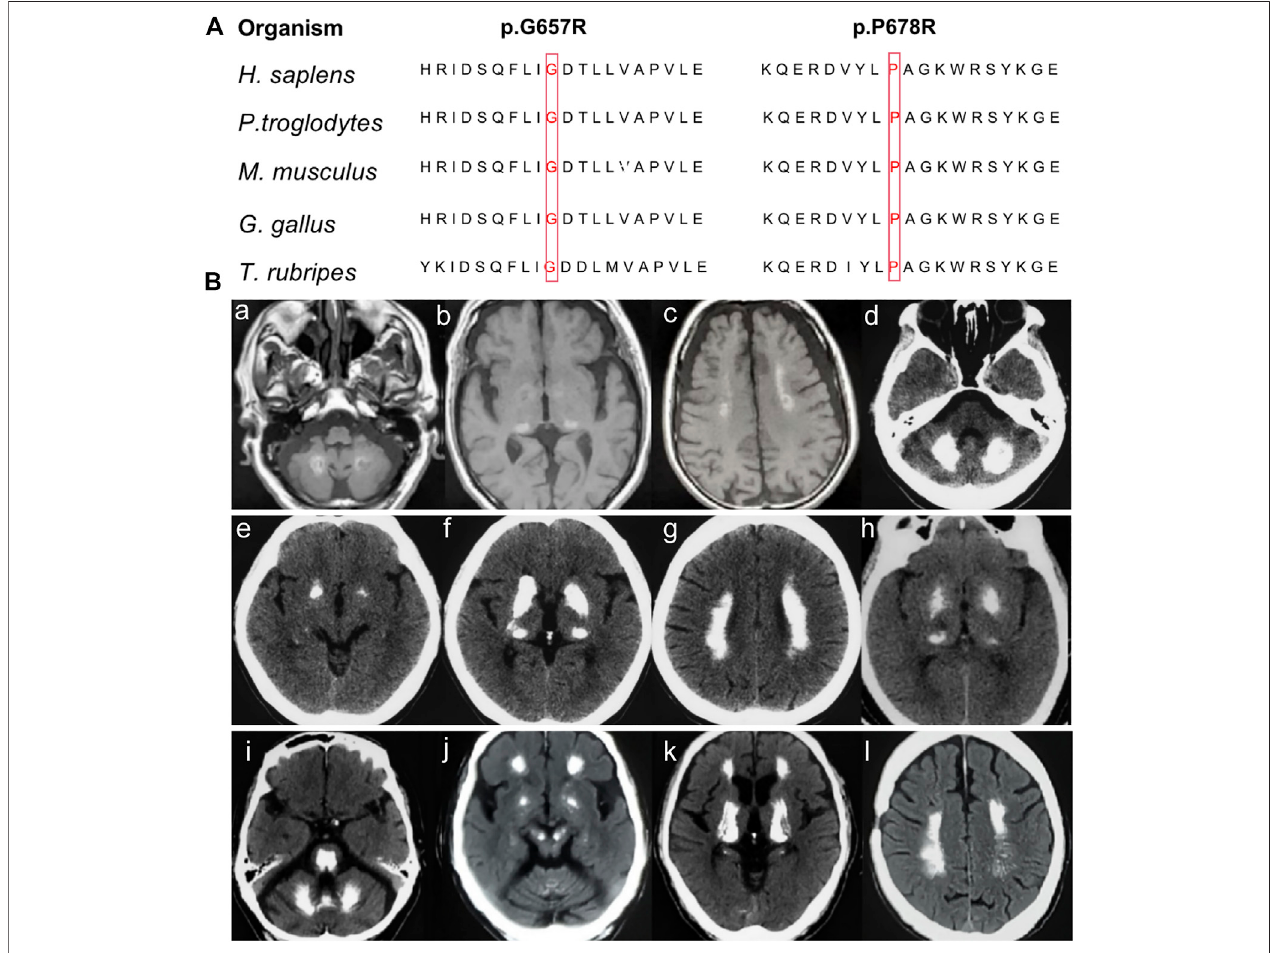
FIGURE 2 | (A) Conservation analysis across species for the novel missense MYORG variants. The variants were marked with red boxes for the corresponding amino acid. (B) Neuroimaging spectrum in the four cases. Cerebral MRI of Case 1 (Ba – c) showed high intensity in the globus pallidus, thalamus, dentate nuclei, and subcortical white matter; CT scan of case 2 (Bd – g) showed symmetrical calci fi cation at the basal ganglia, thalamus, dentate nuclei, and subcortical white matter; case 3 (Bh) showed calci fi cation in the basal ganglia and thalamus; and case 4 (Bi – l) showed prominent calci fi cation in the basal ganglia, thalamus, dentate nuclei, cerebellar vermis, subcortical white matter, and